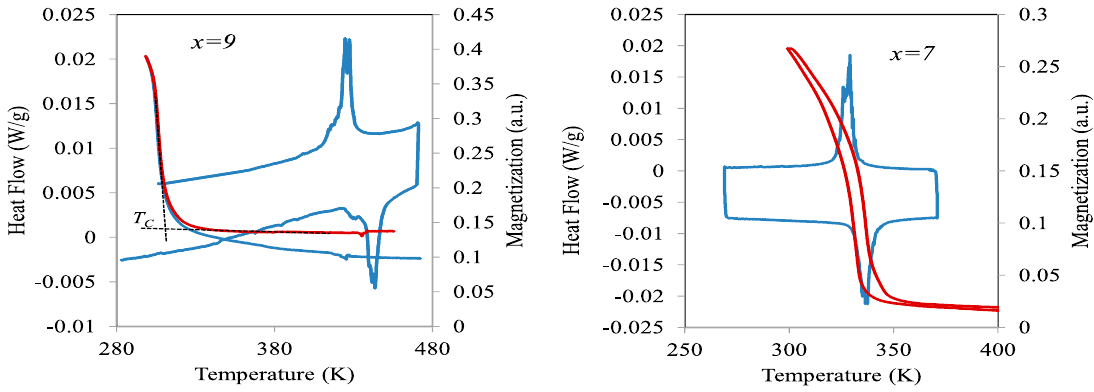
Figure 2. Thermogravimetric curves obtained during cooling / heating cycles performed under a permanent magnet for alloys with x = 9 and x = 7. The corresponding DSC curves are also shown.